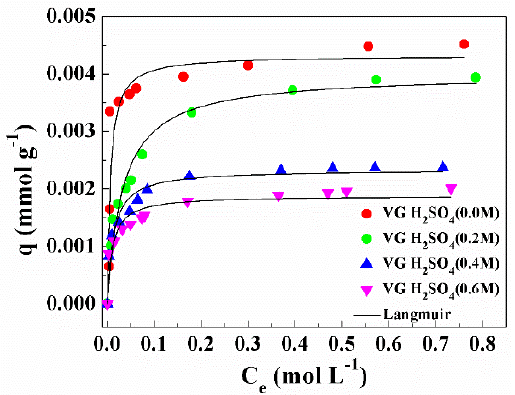
Figure 3. Cu 2+ adsorption in volcanic glass (VG) with acid treatment and activated with H 2 SO 4 (0.2 M, 0.4 M, and 0.6 M) solution.